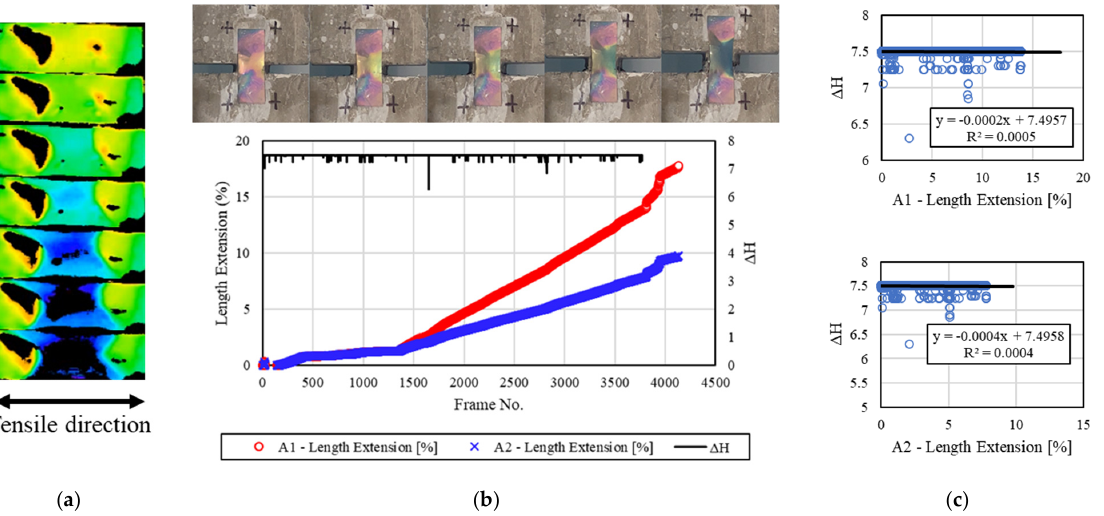
Figure 8. Results for the specimens after 1.5 h. ( a ) H-value image for discoloration color of mecha- nochromic sensor (90° rotation relative to tensile direction); ( b ) variations in strain and dH of A1 and A2 according to image frame. (The discoloration process of the mechanochromic sensor at- tached to the specimen and the tensile strain described in Figure 3 are shown.); ( c ) correlations of dH with A1 and A2.